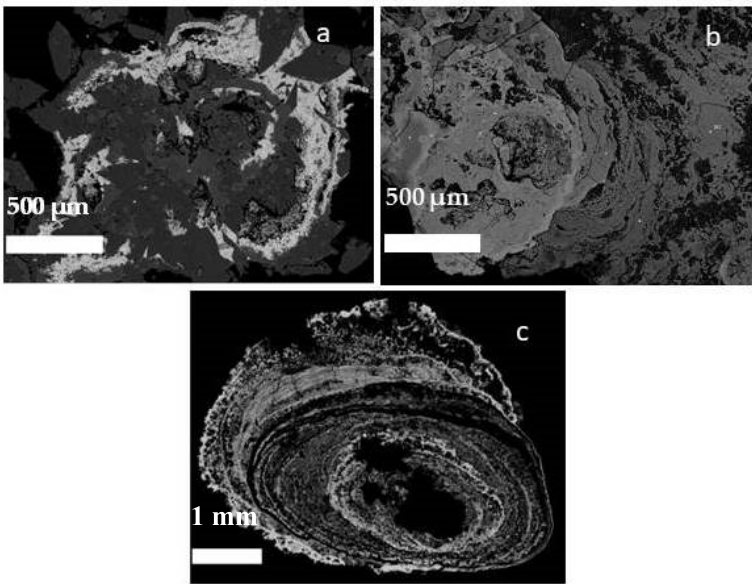
Figure 2. SEM BSE images of the oxalate-bearing stones, Sample 5 ( a ) and the pure phosphate stones, Sample 1 ( b ) and Sample 17 ( c ).